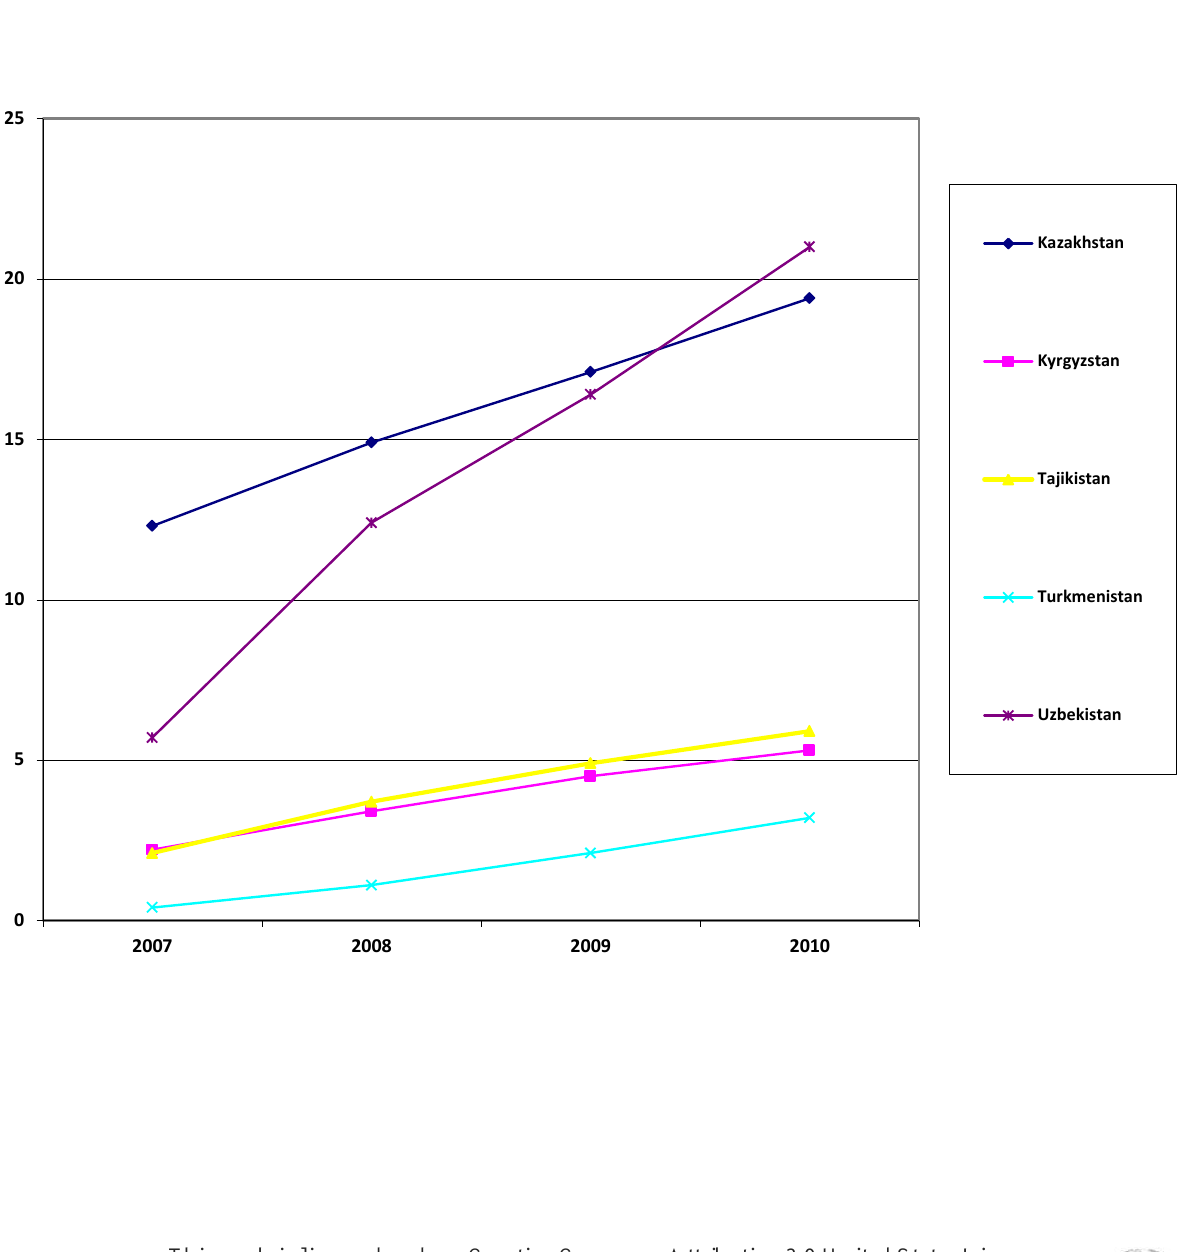
Figure 5: The number of cell phone subscriptions (in millions) for each of the Central Asian countries.